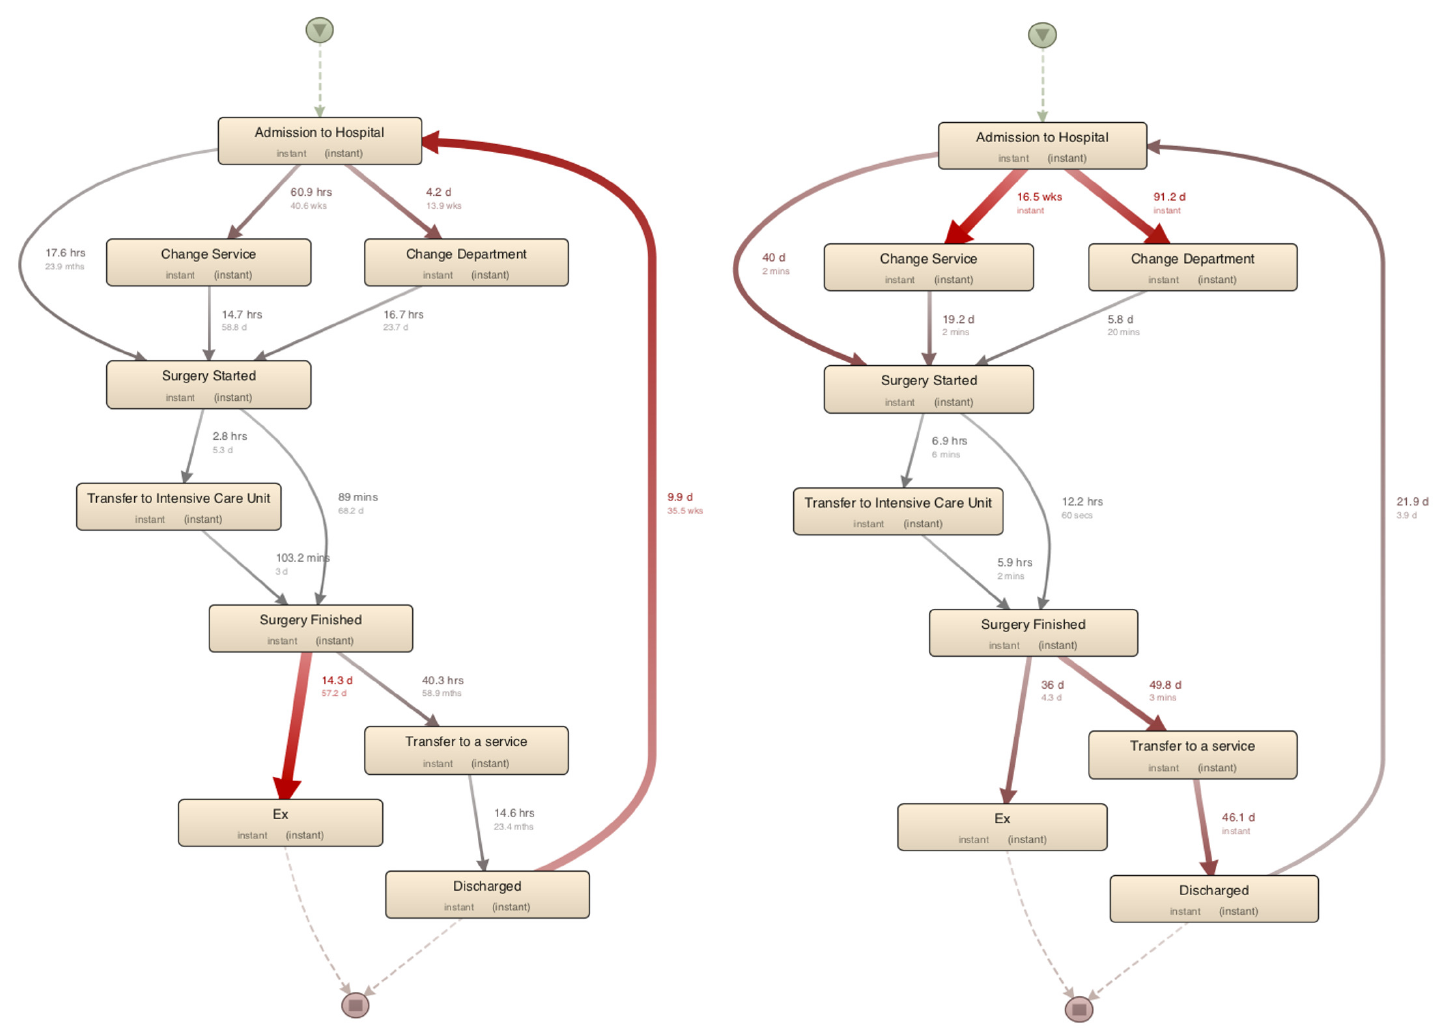
Figure 4. Performance Analysis: ( a ) Total/Mean Duration ( b ) Max/Min